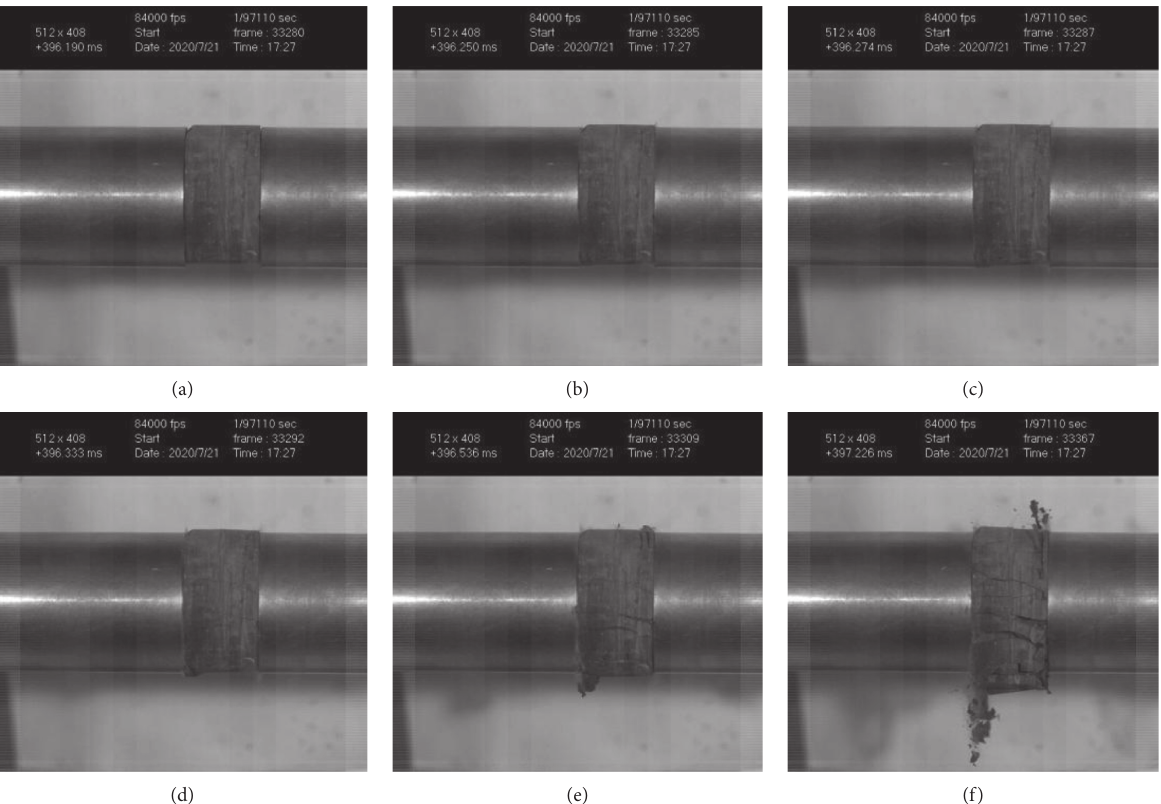
Figure 14: Failure of fracture specimen filled with cement (0.4MPa). (a) 0us, (b) 60us, (c) 84us, (d) 143us, (e) 346us, and (f) 1036us.